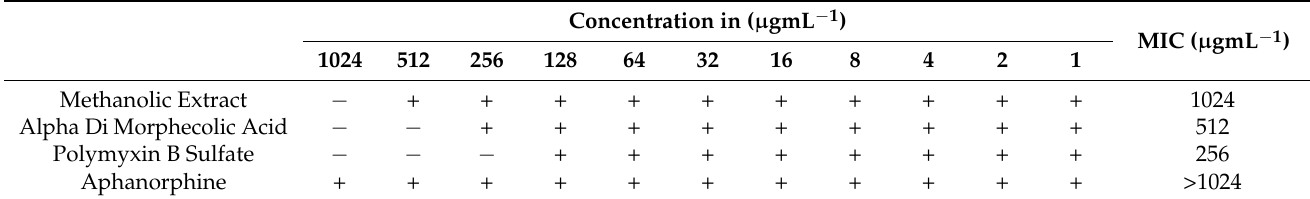
Table 4. Minimum inhibitory concentration of Oscillatorial Methanolic Extract, Alpha dimorphecolic acid, Polymyxin B sulfate, and Aphanorphine against B. subtilis (MTCC 441).